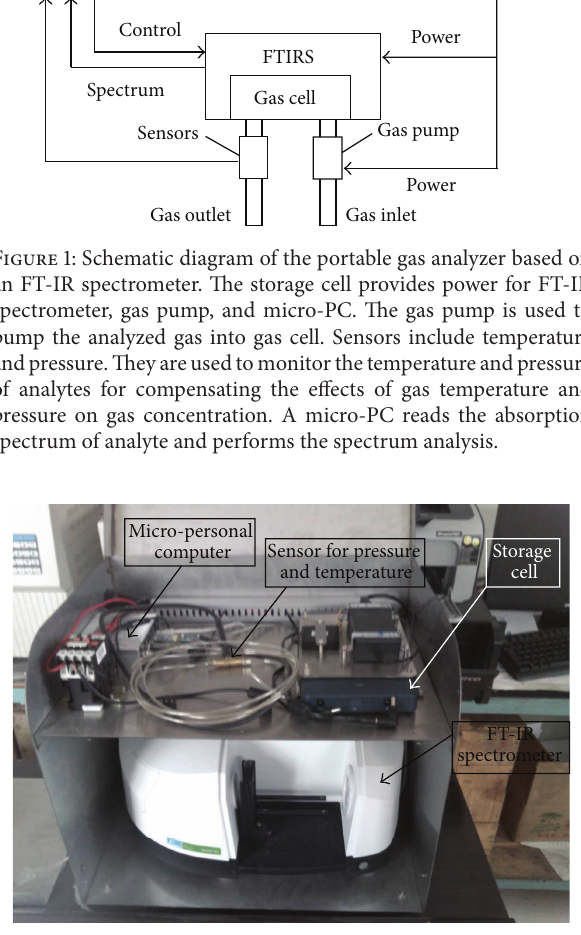
Figure 2: Photo of the portable gas